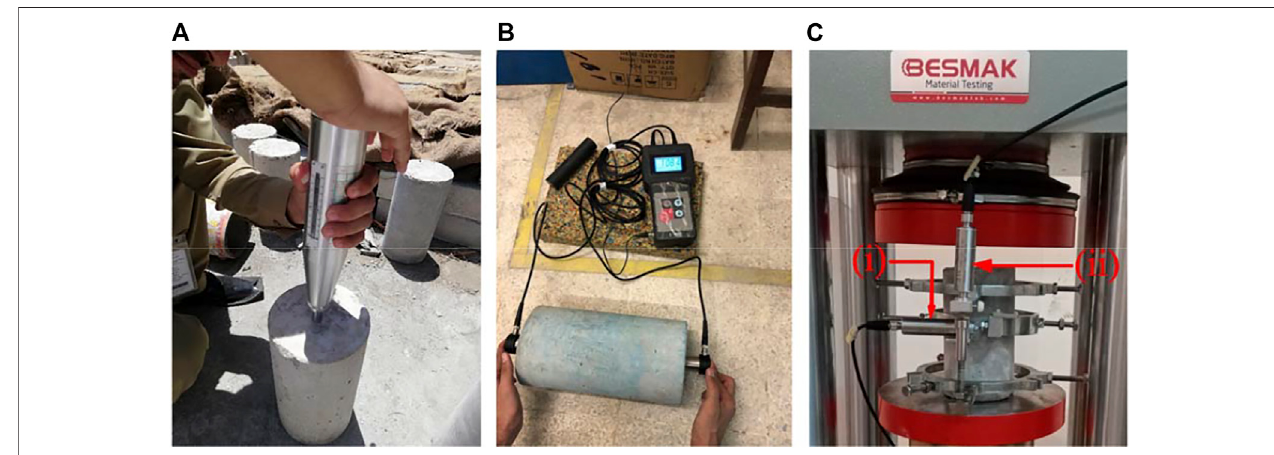
FIGURE 6 | Testing of concrete cylinders. (A) Schmidt hammer testing. (B) Ultrasonic pulse velocity testing. (C) Compression testing: (i) LVDT for lateral deformation and (ii) LVDT for axial